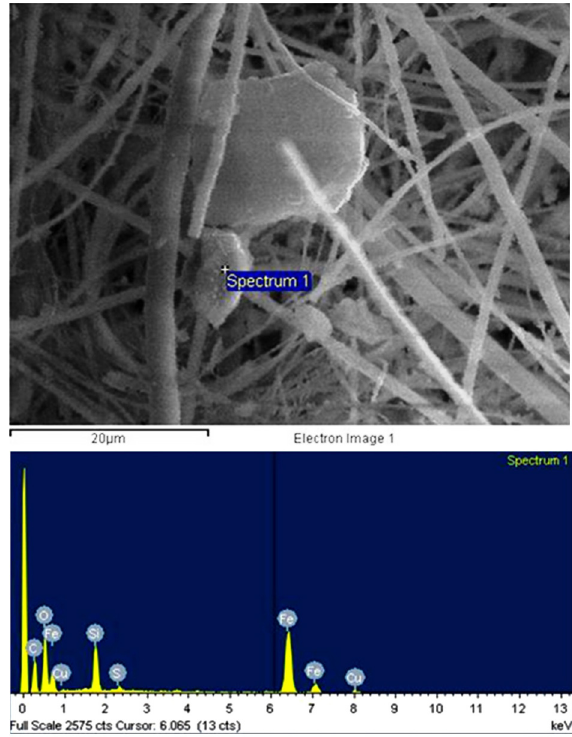
Figure 5. SEM micrograph and EDS spectrum of the mineral phase, corresponding to Siderite (FeCO